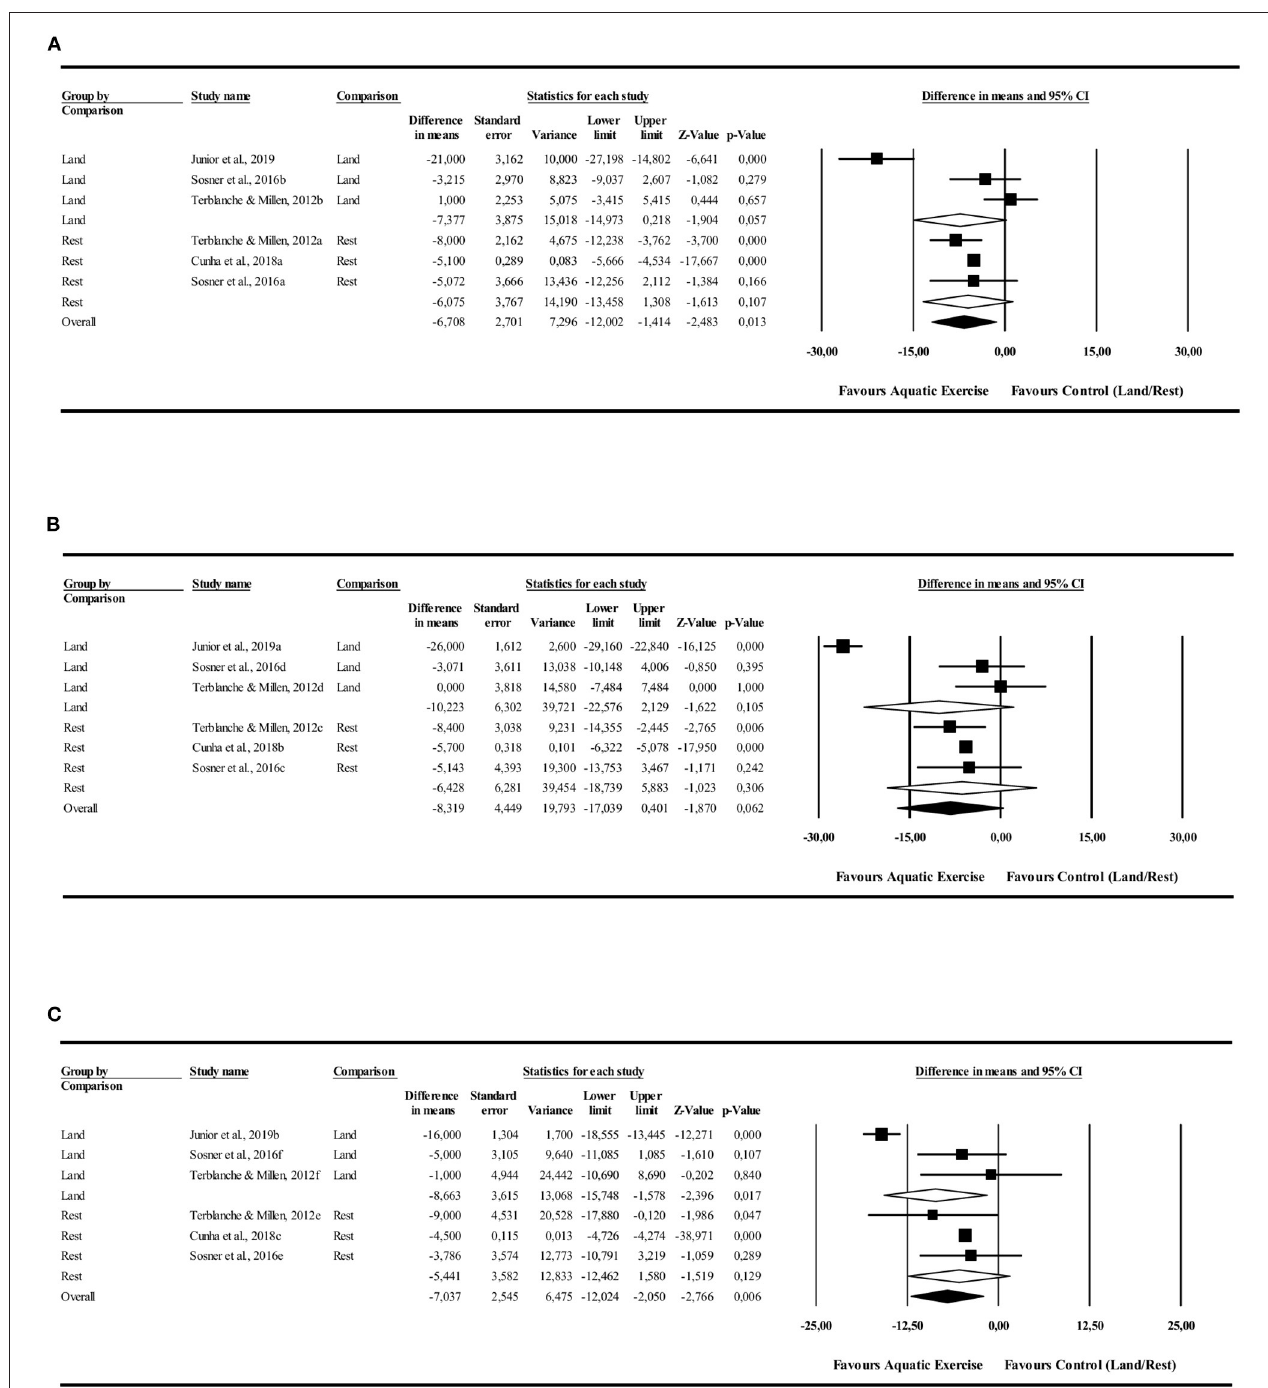
FIGURE 2 | Systolic blood pressure post-exercise hypotension effect. Comparison between water exercise (aquatic) with land exercise or rest condition. (A) 24h, (B) Daytime, (C) Nighttime.